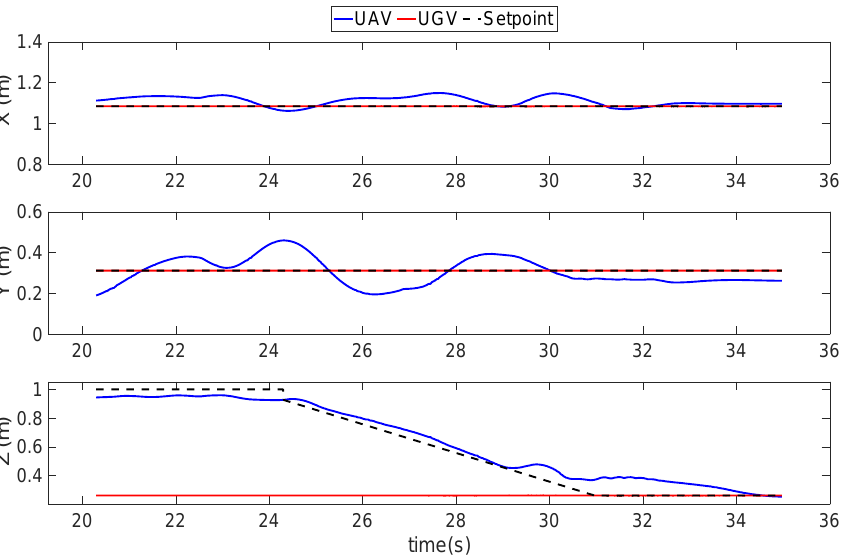
Figure 11. Position results of a quadrotor UAV conducting a conventional vertical landing trajectory.